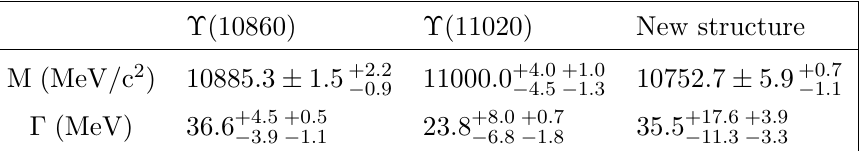
Table 3 . Measured masses and widths of the (cid:7)(10860), (cid:7)(11020) and the new structure. The (cid:12)rst uncertainty is statistical, the second is